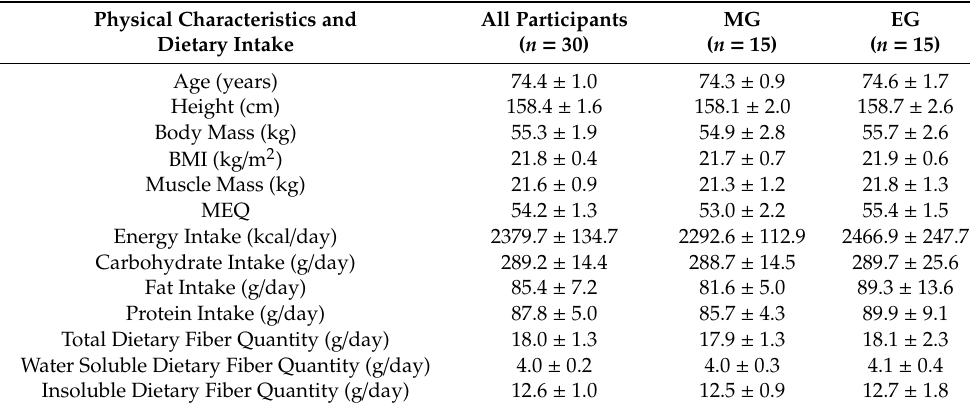
Table 1. Baseline characteristics of study participants.